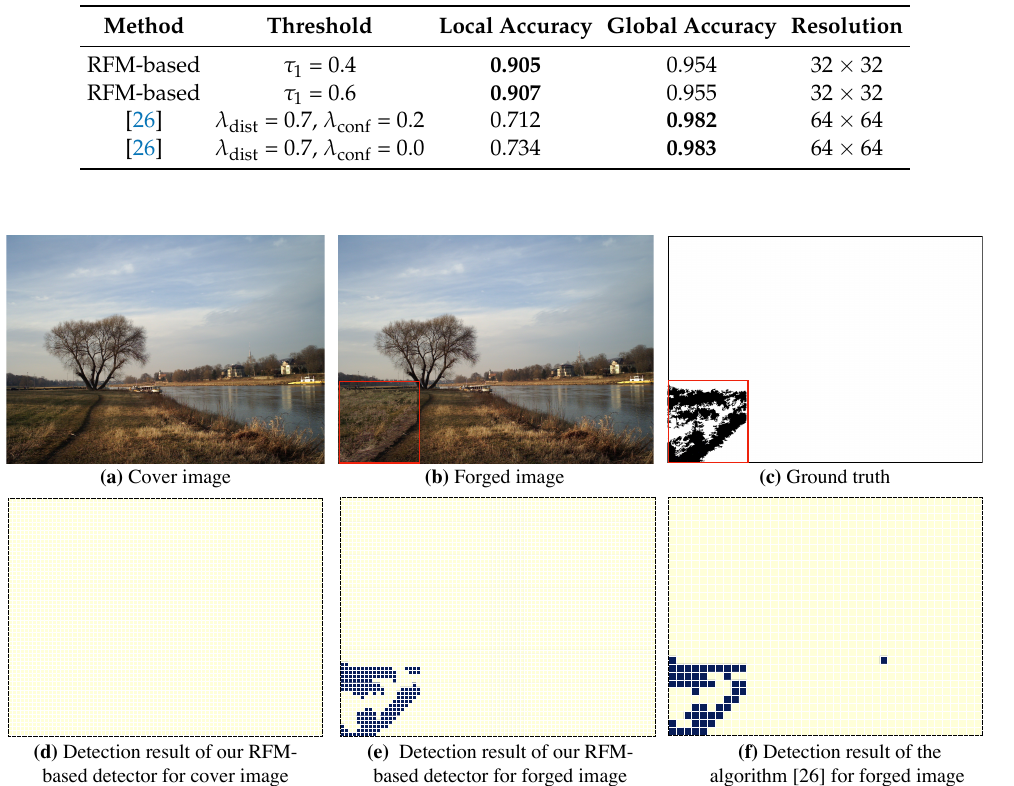
Table 3. Tampering localization comparison between our RFM-based detector and the algorithm of [26].